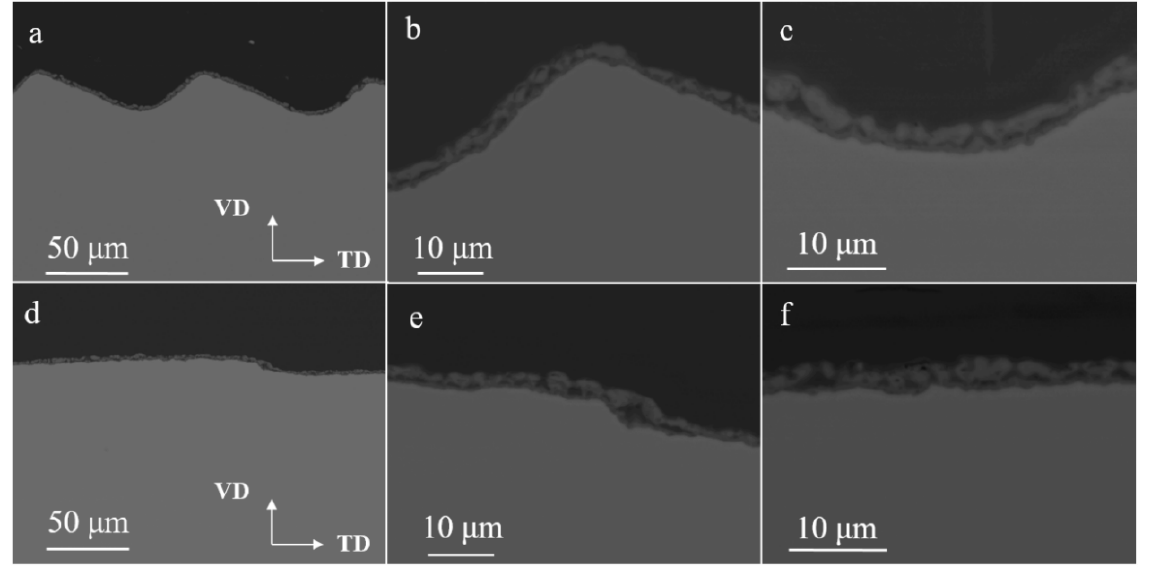
Table 6. Thickness measurements of the flash-PEO coatings on the EB-structured samples. Values obtained from cross-section images in Figures 7, 10 and 12, respectively.